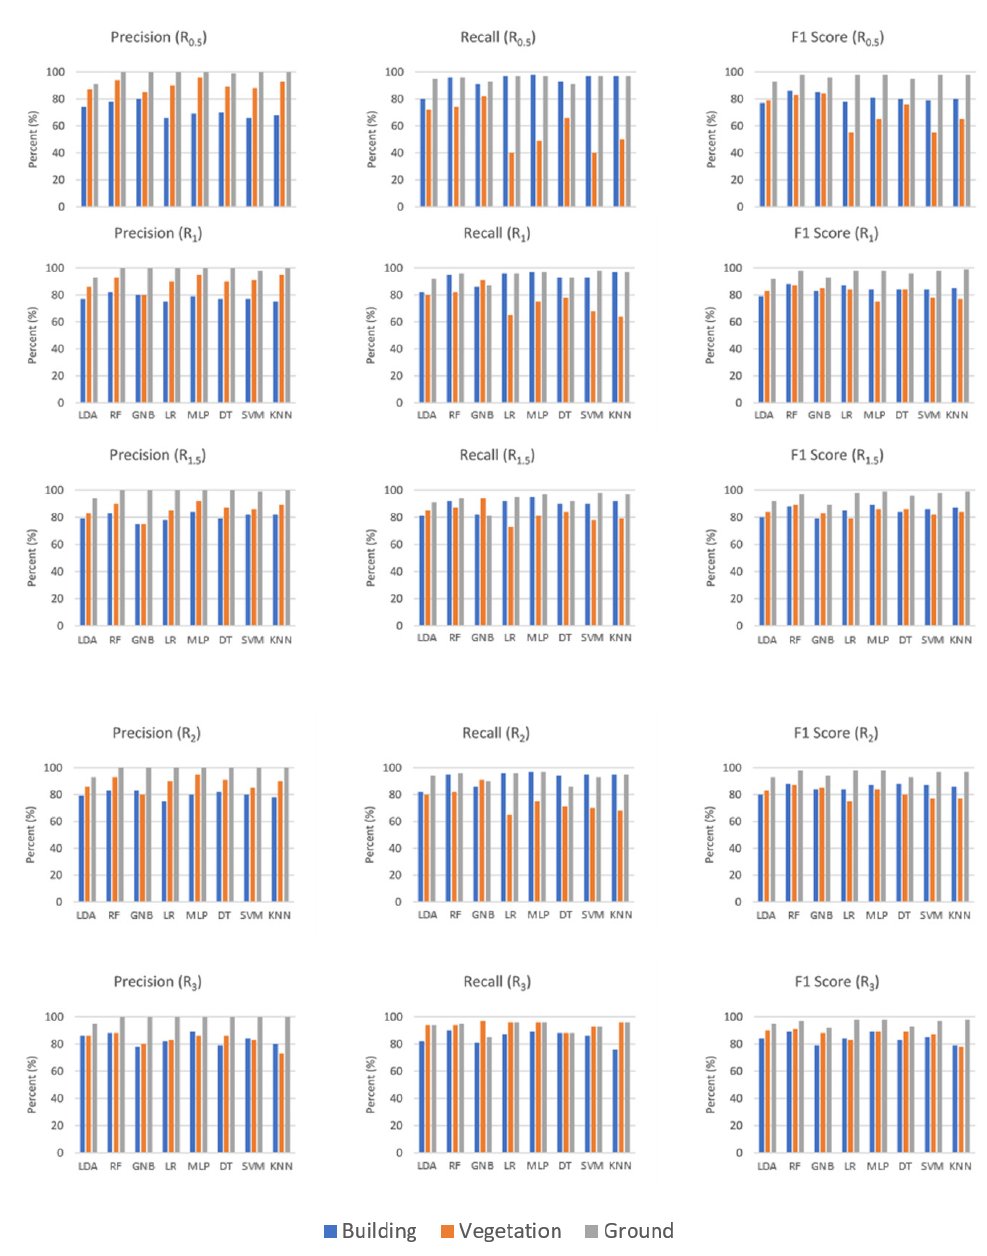
Figure 12. Precision, recall and F1 score values of the algorithms for Dublin City Area 1. In Dublin City Area 2, there were some differences from Dublin City Area 1. While all values increased rapidly in support radius greater than R 0.5 in Area 1, the values of metrics at a small radius in Area 2 did not increase in the same way. High metric values were obtained in the support of R 3 for almost all methods. Although precision was not affected by the radius change, recall and F1 score had low values in the support of R 0.5 . MLP and LR (in R 3 support), the best methods for building class extraction, had 97% and 96% F1 scores, respectively. The method with the lowest F1 score was the LDA method with 89% (in R 3 support). Vegetation class was detected with lower success in all sup- ports than other classes. For the vegetation class, RF was the most successful method in